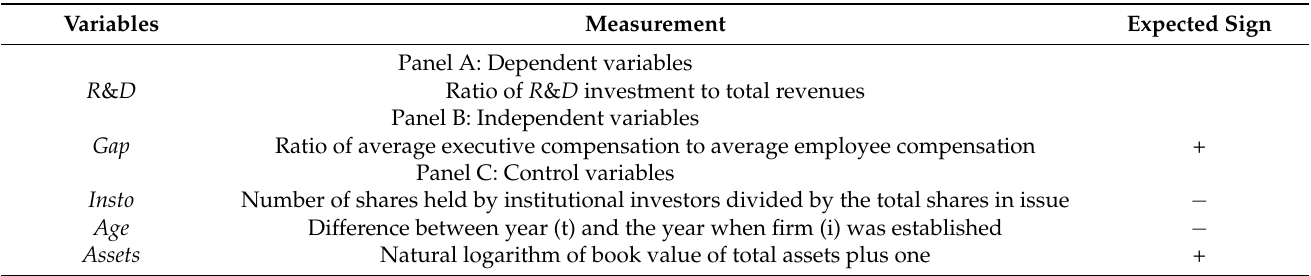
Table 1. Variable